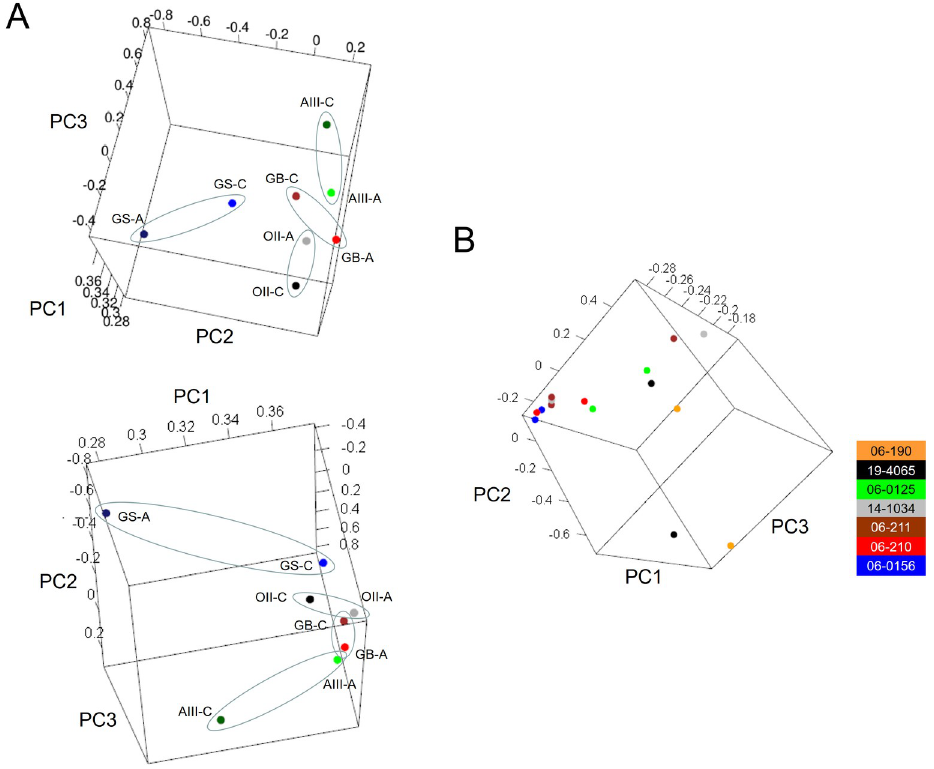
Fig 3. The transcriptional profiles of the tumour aspirates and core resections are similar. 3-D PCA of our samples ( A ) and the samples from the TCGA repository ( B ). C = tumour core resection. A = cavitational ultrasonic surgical aspirate. The colouring scheme indicates the patient ID of the TCGA from which the different tumoural resections were obtained.